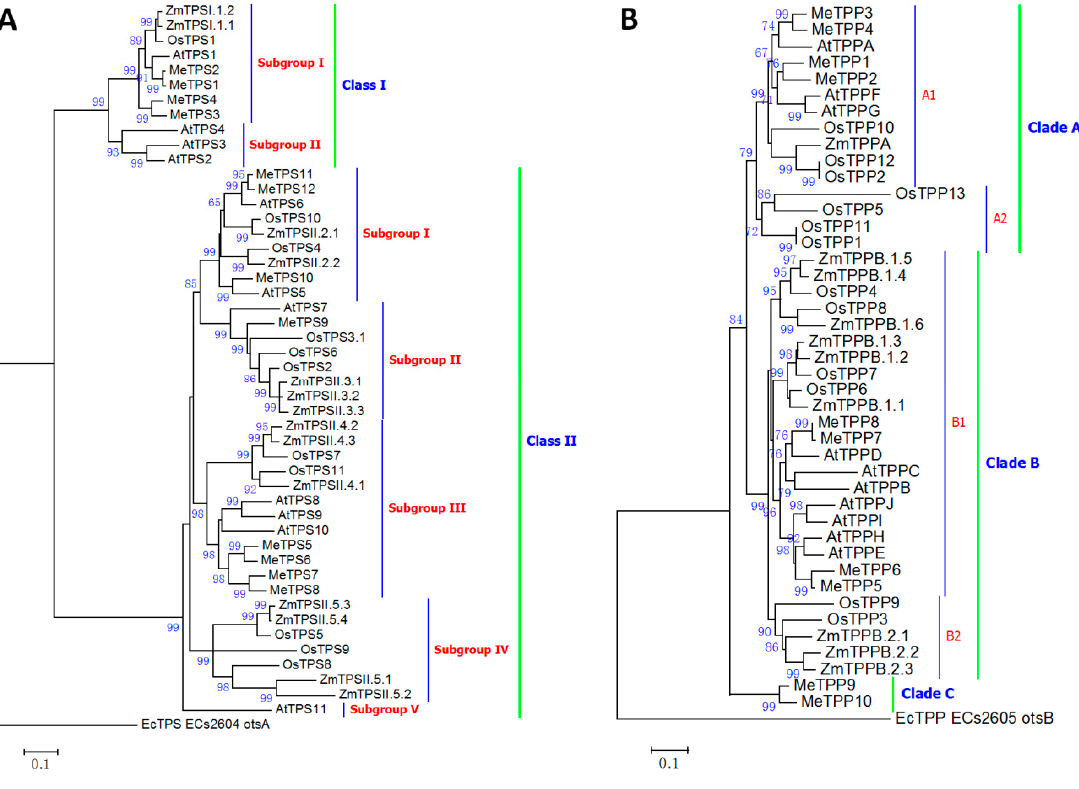
Figure 5. Phylogenetic classification of trehalose-6-phosphate synthase (TPS, A ) and trehalose-6-phosphate phosphatase (TPP, B ) proteins. The sequences were aligned with ClustlX2 [41], and phylogenies were built using MEGA 7 [42]. Maximum Likelihood (ML), Neighbor-Joining, and Minimum-Evolution methods were used in the phylogenetic analysis and only the ML trees are shown. The confidence probabilities (multiplied by 100) that the interior branch length is greater than 0, as estimated using the bootstrap test (1000 replicates), are presented at the relevant nodes. Scale bars represent 0.1 residue substitution.